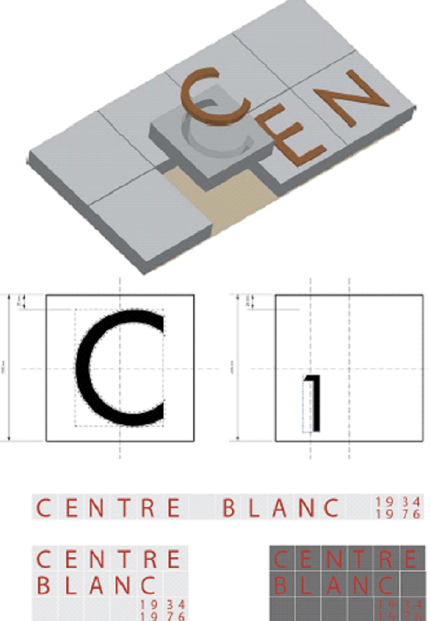
Preliminary ideas regarding the use of panot as the main element to signal the points of the Space Remembrance System. Master in Urban Design (Laboratory